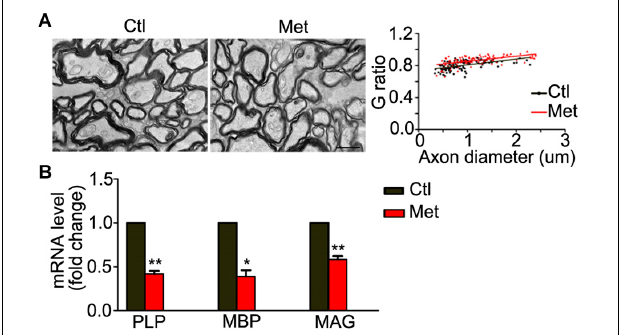
FIGURE 5 | Analyses of myelin ultrastructure in the frontal white matter after Met treatment. (A) Representative electronic microscope pictures showing the myelin sheath in Ctl and Met group mice. The graph shows the quantification of G ratio ( n = 3 for each group, P < 0.001). (B) The quantification of transcripts of MBP, PLP, and MAG in Met group, which is normalized to Ctl mice ( n = 3 for each group). Scale bar = 1 µ m. The data are expressed as the mean ± SEM. * P < 0.05; ** P <